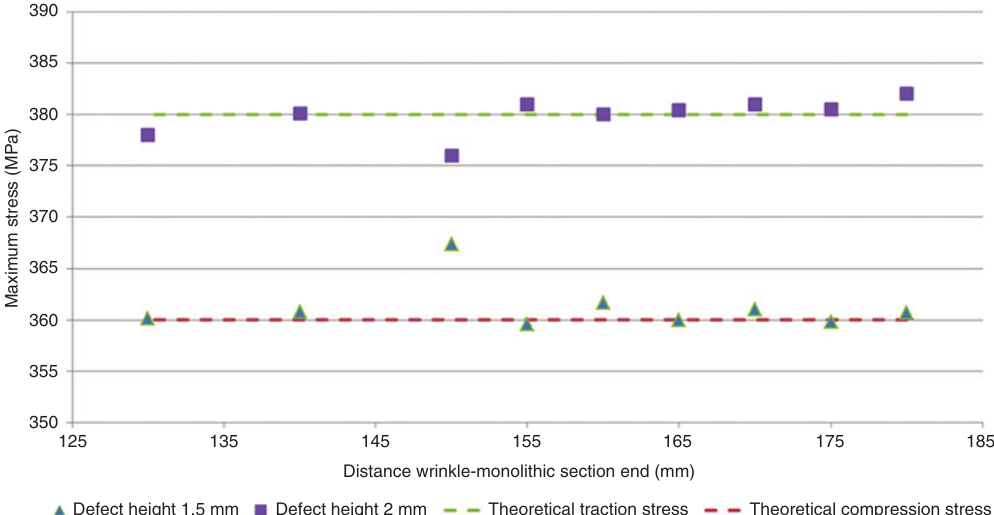
Figure 5 Influence of wrinkle dimensions in maximum stress in compression